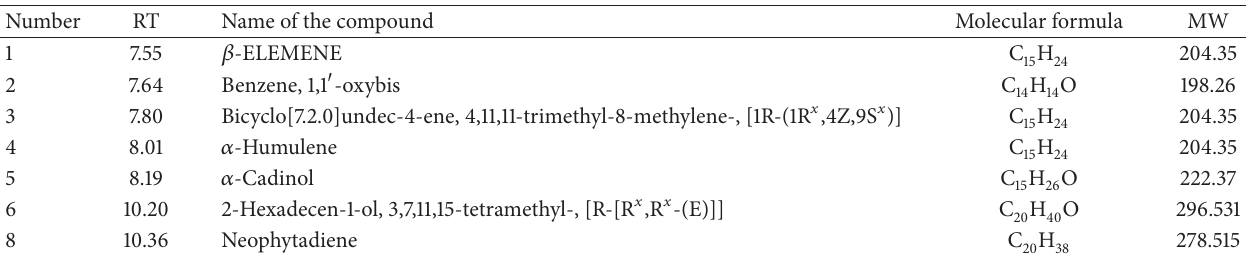
Table 1: The active principles in the leaf extract of Centella asiatica with their retention time (RT), molecular formula, and molecular weight. Number